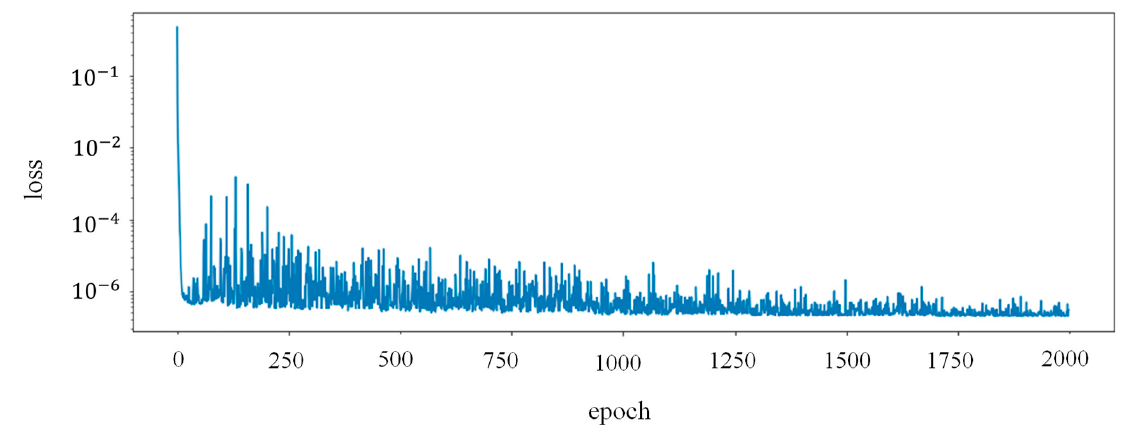
Figure 17. Loss function of the PINN.